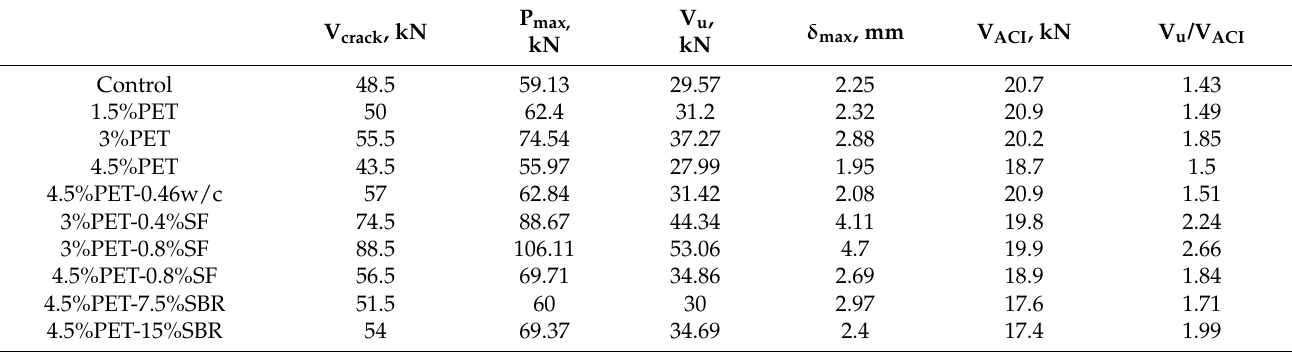
Figure 7. Load vs. mid-span deflection curves for the control and PET-modified RC beams. Table 4. Shear strength properties of investigated RC beams.